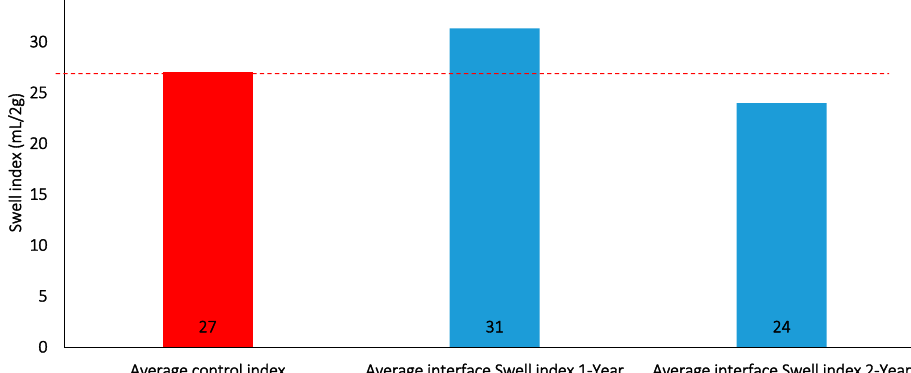
Figure 21. Interface swell index for 1 and 2-year batch tests.